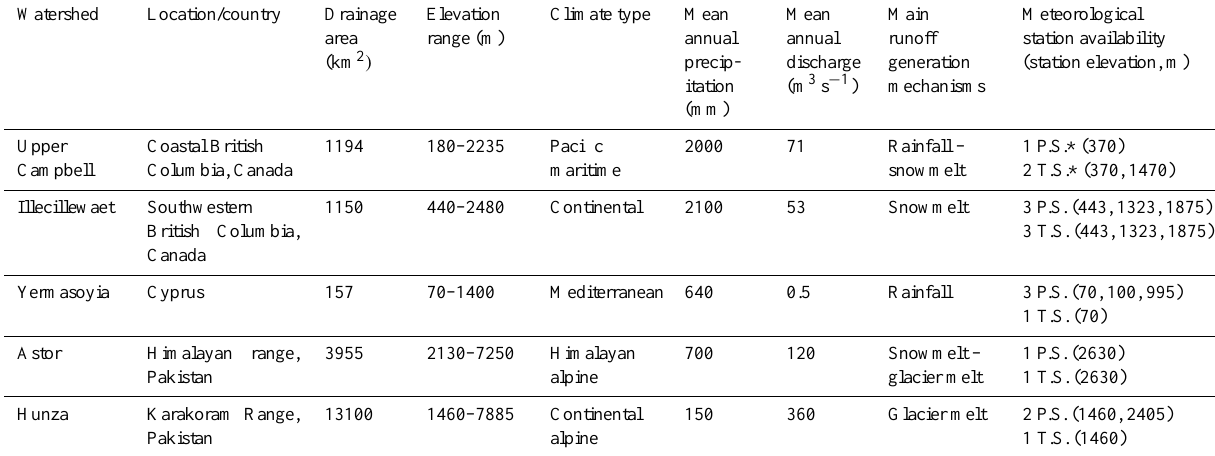
Table 1. Characteristics of the five study